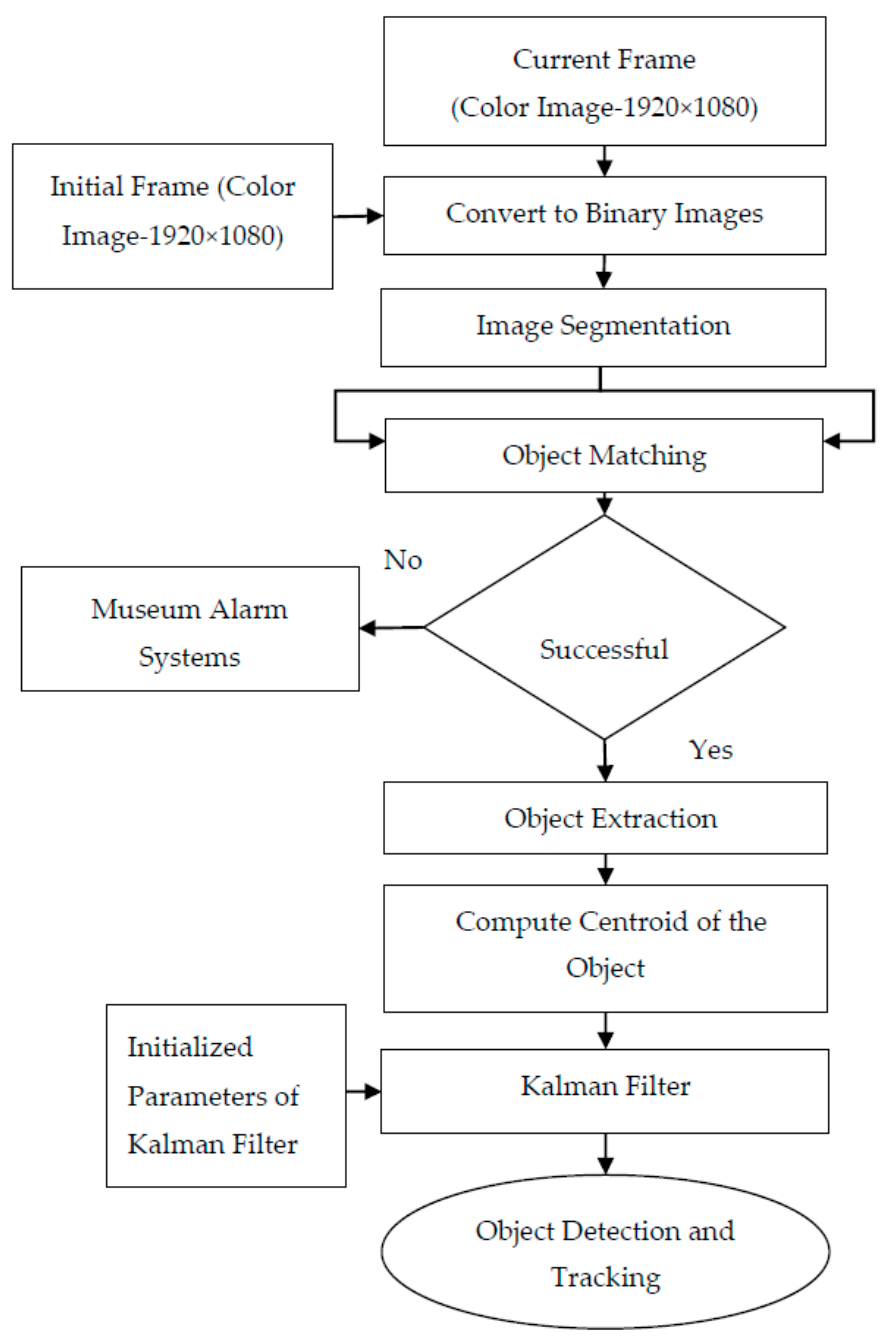
Figure 9. Flowchart representation for object detection and tracking.